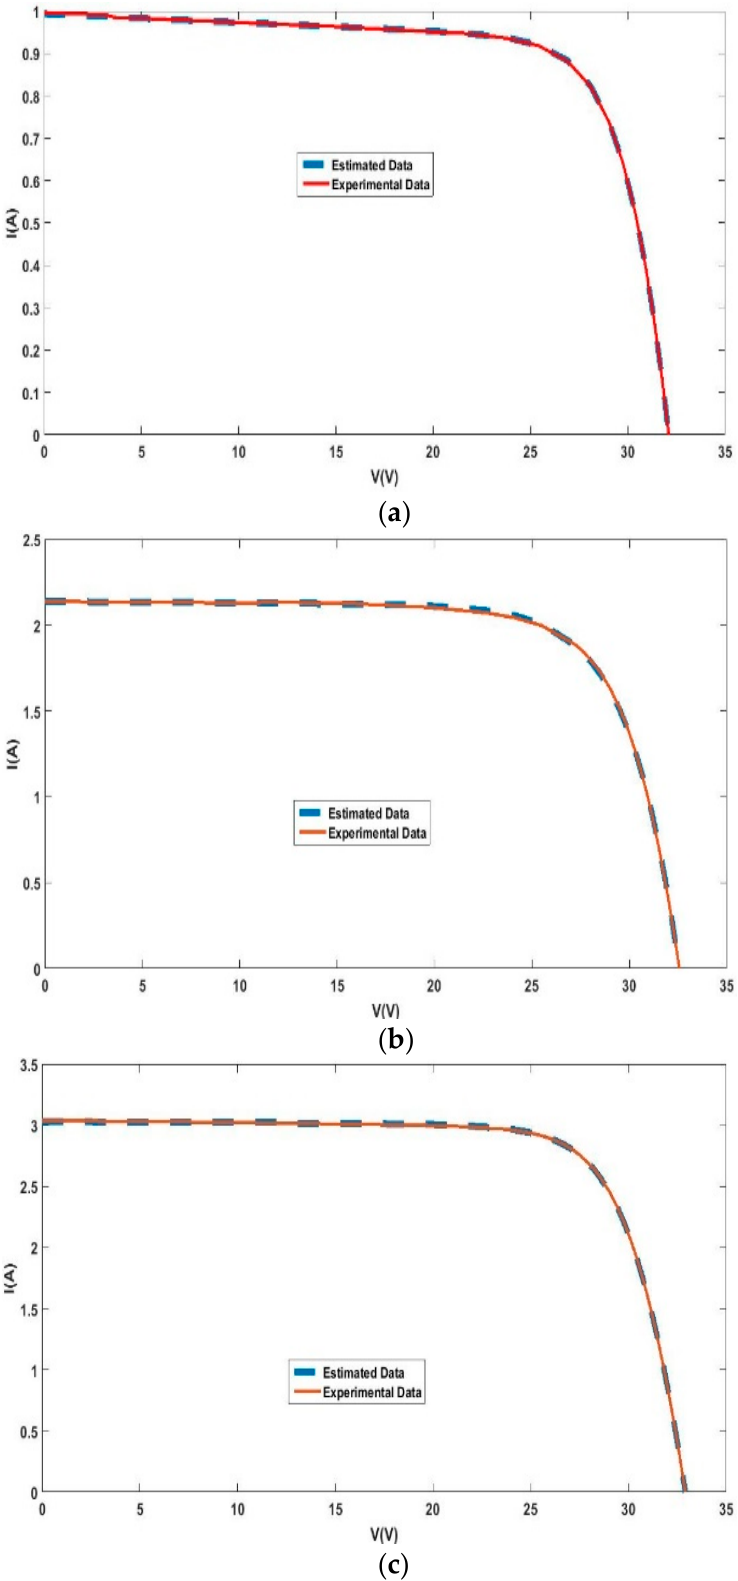
Figure 11. Estimated V-I versus experimental V-I at different environmental impacts using EHO for MTDM;( a ) at 109.2 W/m 2 and 310.32 K, ( b ) at 246.65 W/m 2 and 313.32 K, and ( c ) at 347.8 W/m 2 and 316.95 K.